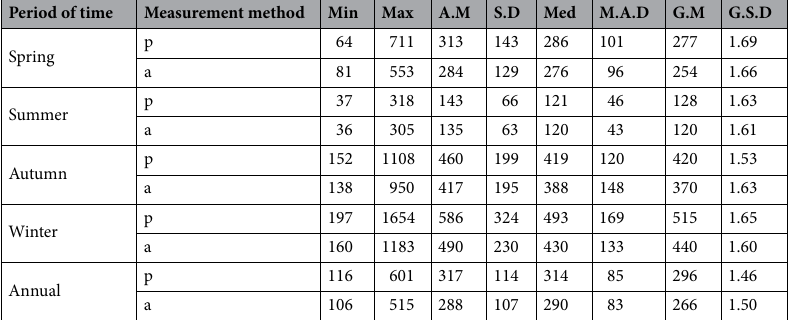
Table 1. The descriptive statistics of indoor radon concentration (Bq/m 3 ) depending on the season and the measurement method in 71 retrofit houses. p—passive measurements using CR-39 detectors; a—active measurements using ICA system with TSRS2 radon sensor; A.M.—arithmetic mean; S.D.—standard deviation;